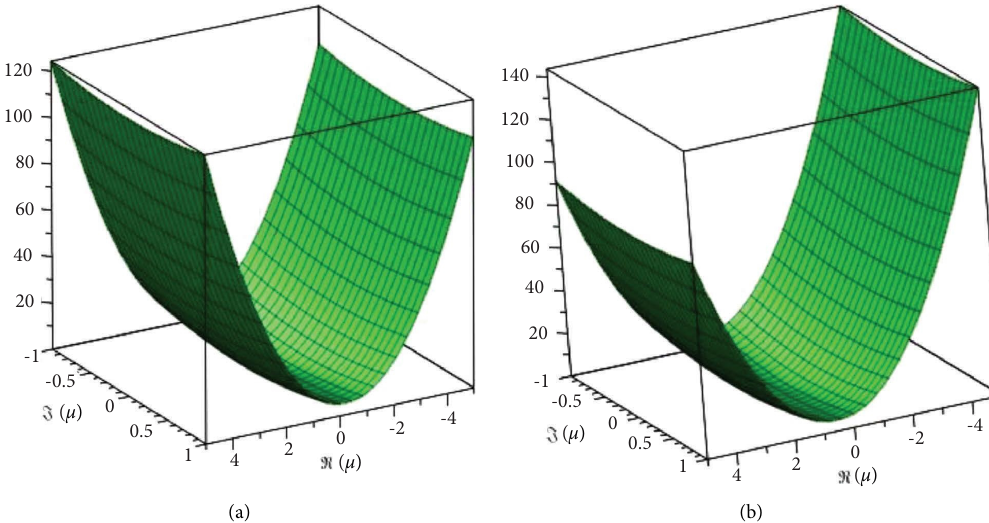
Figure 6: For varying Z and η values, the spreading level of diagonized cases are constantly increasing (a) C